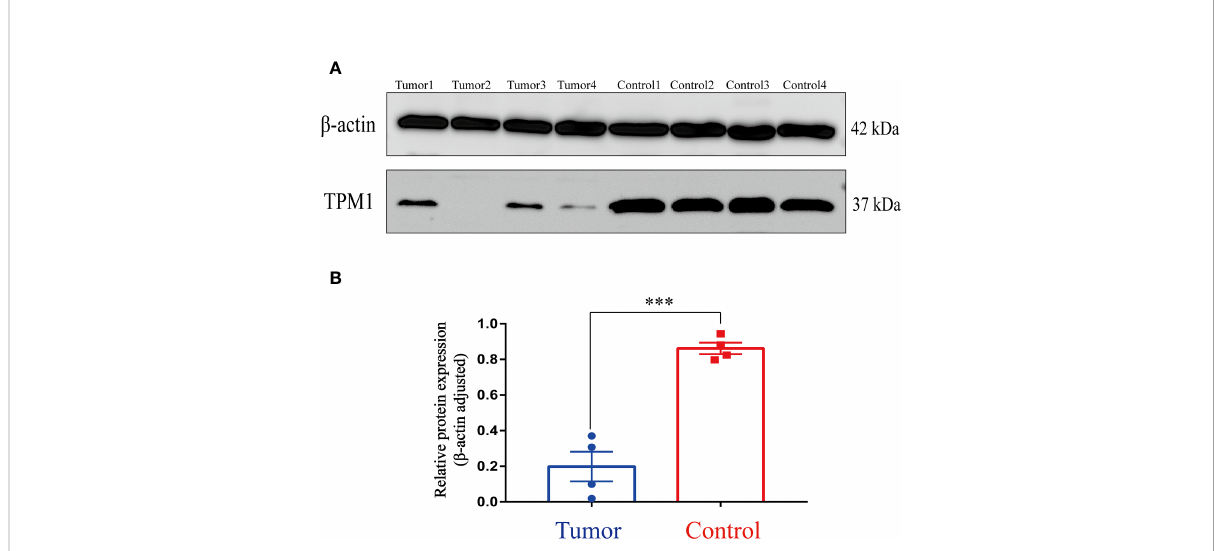
FIGURE 5 Western Blotting. (A) TPM1 protein expression in the tumor and control group. (B) *** P <